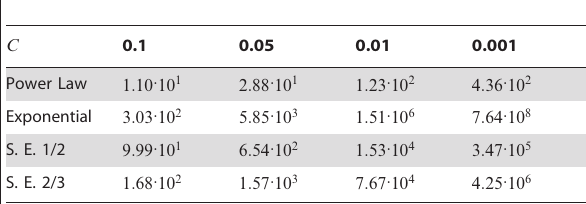
Table 3. Most Likely t c for Values of C (in seconds).